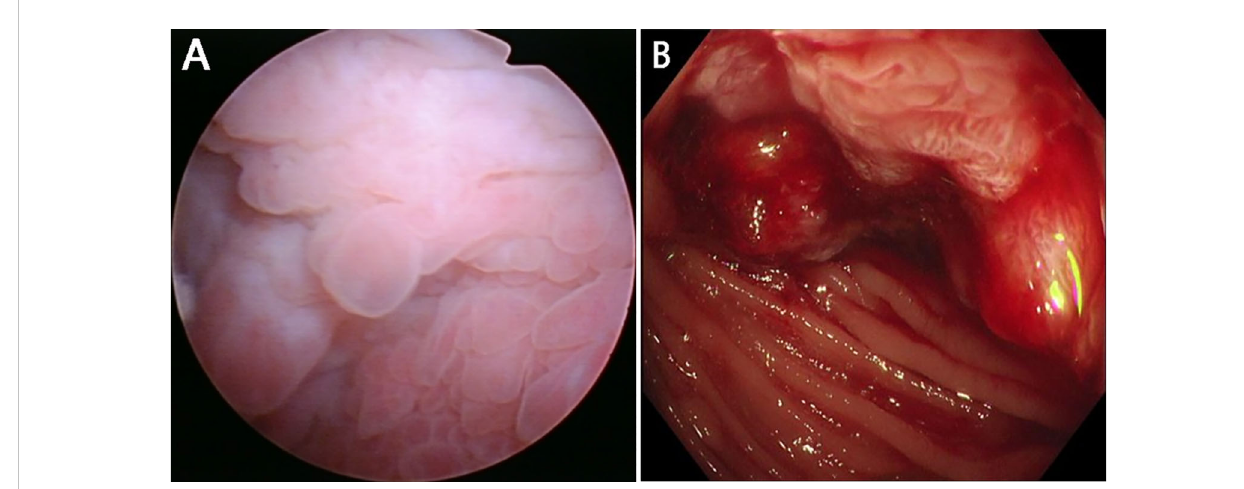
FIGURE 2 (A) : Cystoscopic examination. Changes in the mucosa of the bladder were noted; (B) : Colonoscopy. Sigmoid colon cancer was revealed which occupied nearly the entire colon.